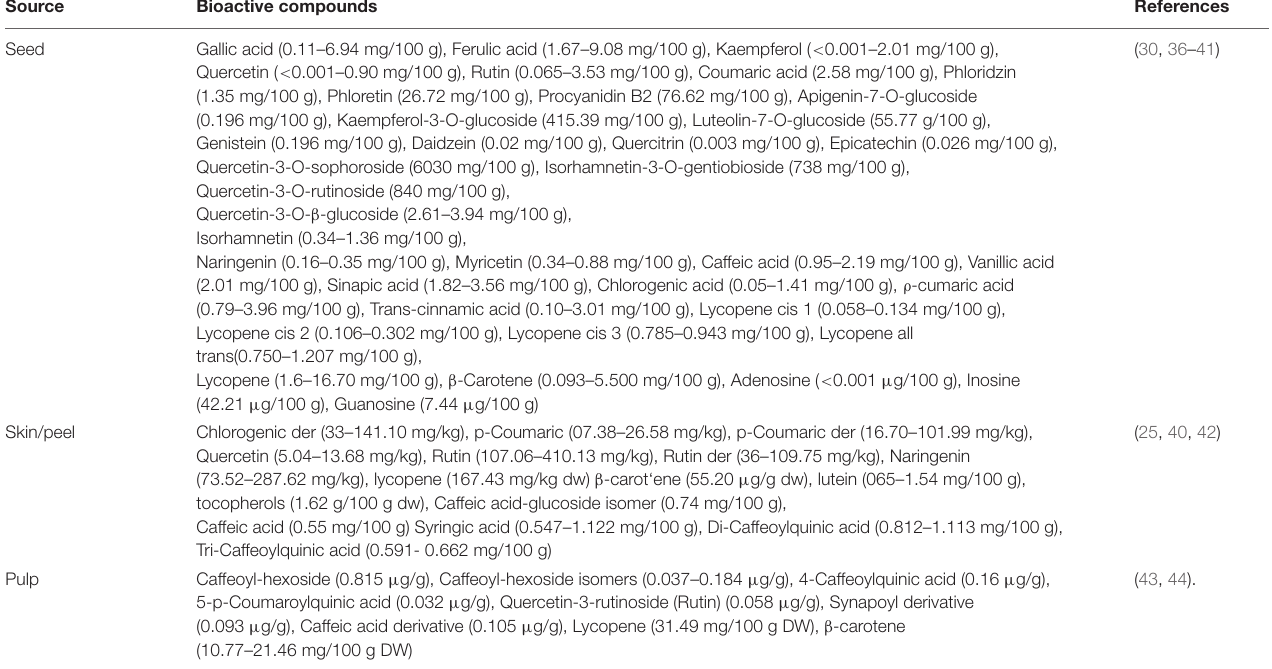
TABLE 1 | Different bioactive compounds reported in seed, skin, and pulp of tomato.